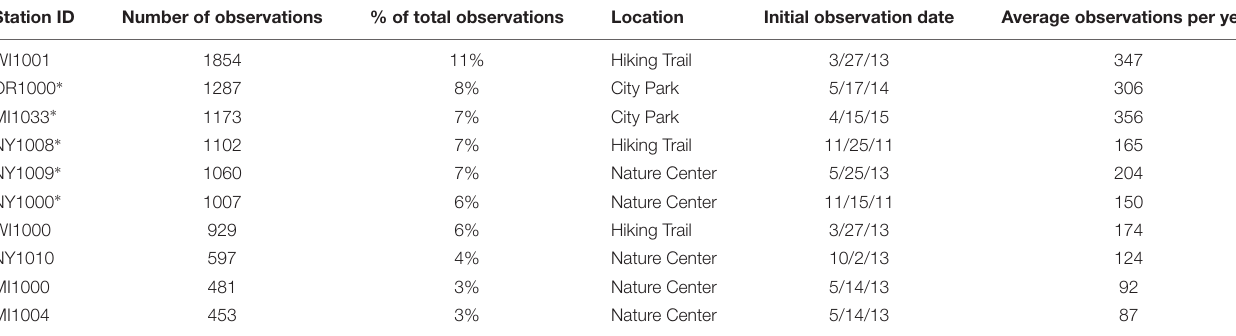
TABLE 1 | Top ten CrowdHydrology stations based on total number of